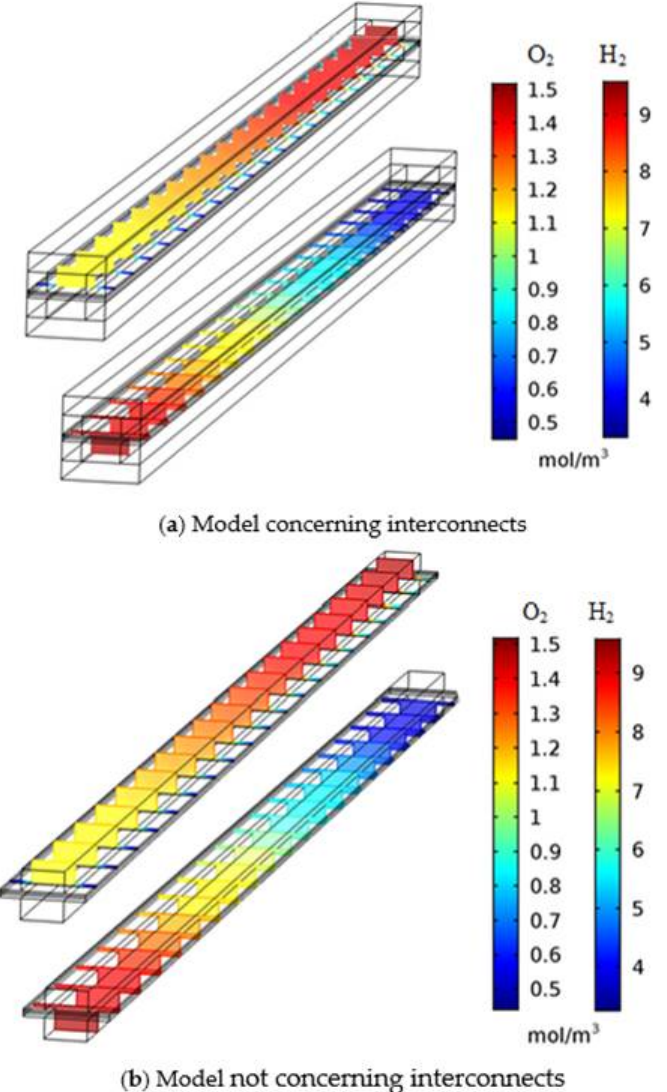
Figure 5. Distribution of mole fractions of oxygen and hydrogen along the cathode channel: ( a ) model concerning interconnects and ( b ) model not concerning